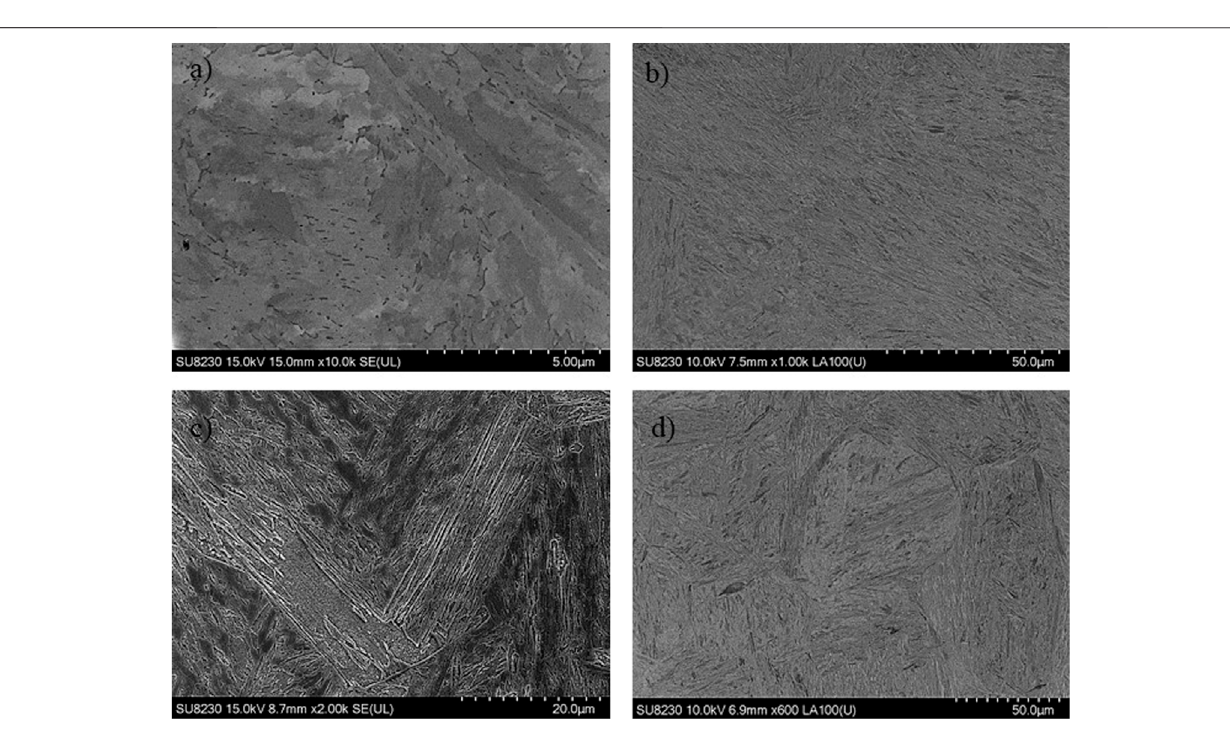
Frontiers in Mechanical Engineering |